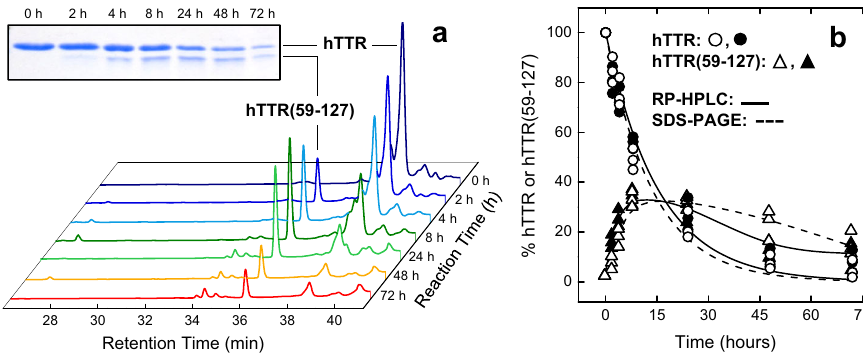
Fig. 2 Time-course analysis of hTTR proteolysis by subtilisin. hTTR (1 mg/ml) was reacted in TBS, pH 7.4, containing 5 mM CaCl 2 , with subtilisin (0.9 μ M) at an enzyme/hTTR ratio of 1:20 (mol/mol) at 37 °C. At increasing time points, the proteolysis mixtures were acid-quenched and aliquots (20 μ g) analysed by RP-HPLC and SDS-PAGE. a RP-HPLC waterfall plot of hTTR proteolysis by subtilisin. Aliquots of the reaction mixture were loaded onto a C18 analytical column and eluted with a linear aqueous acetonitrile-0.1% TFA gradient from 10 to 45% in 30 min, at a fl ow rate of 0.8 ml/min. The absorbance of the ef fl uent was recorded at 226 nm. Inset SDS-PAGE (4 – 20% acrylamide) analysis was carried by loading aliquots (5 μ g) of the reaction mixture under reducing conditions, followed by Coomassie staining. b Time-course plot of hTTR degradation (circles) and hTTR(59 – 127) generation (triangles) monitored by RP-HPLC (solid line) or SDS-PAGE (dashed line). Data points were obtained by integrating the chromatographic peak areas or by densitometric analysis of the gel bands in a . The data relative to hTTR proteolysis were fi tted with Eq. (1) (Supplementary Information), to yield an observed, cumulative kinetic constant, k , of hTTR hydrolysis ( k = 1.6 ± 0.2 × 10 − 5 s − 1 ) for both chromatographic and electrophoretic data. The data were obtained from three different measurements. The fi tting curves relative to hTTR(59 – 127) generation are only intended to help the reader to follow the data